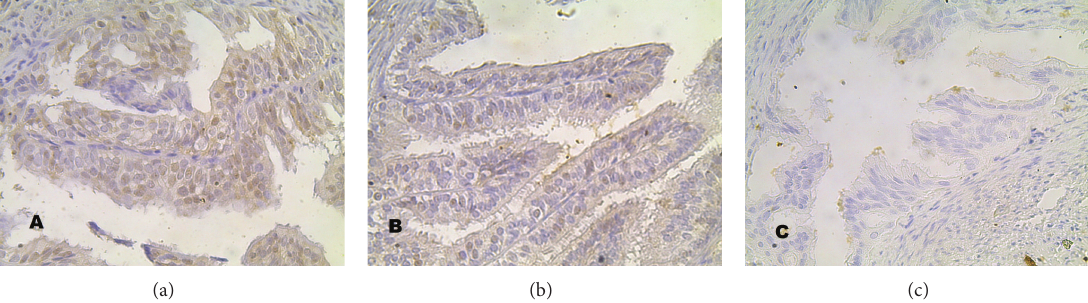
Figure 3: Expression of caspase 3 in oviduct epithelial cells of the control group (C), as well as study groups A and B (mag. x400). The highest intensity expression in group A, the lowest in the control group.